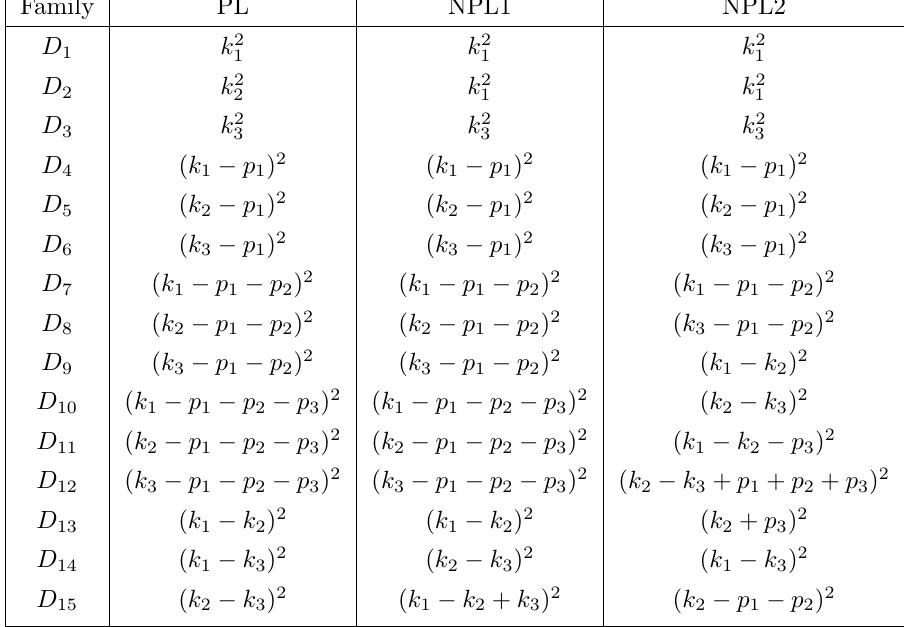
Table 3 . Planar and non-planar 3-loop integral